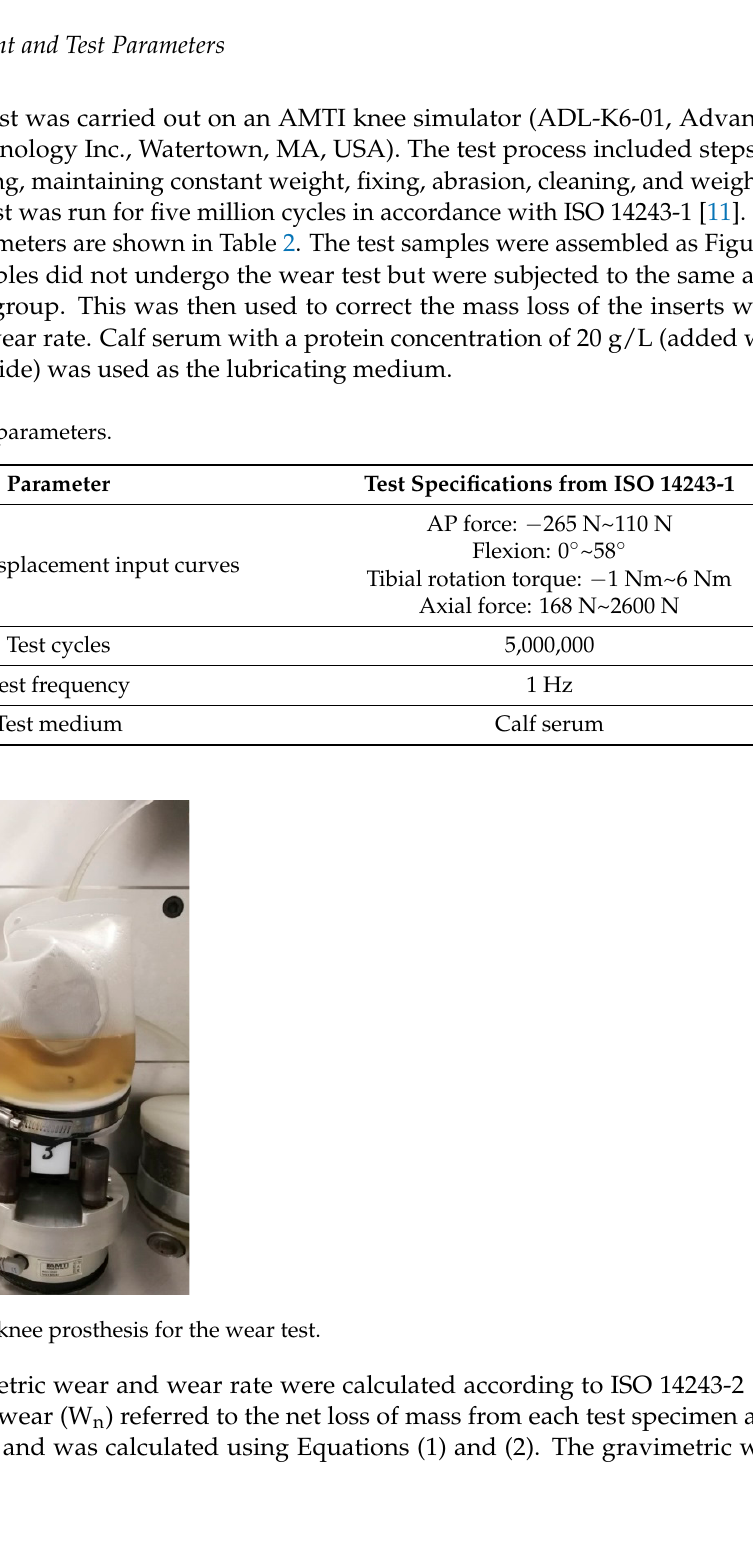
Table 1. The tensile properties of the materials.